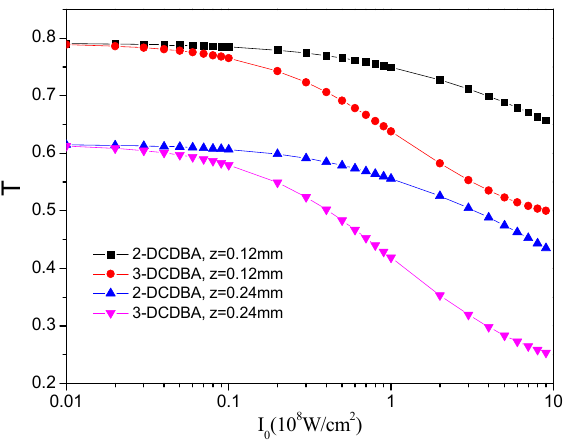
Figure 3. Field intensity transmittance as a function of the 2-DCDBA and 3-DCDBA incent light field at different propagation distances.